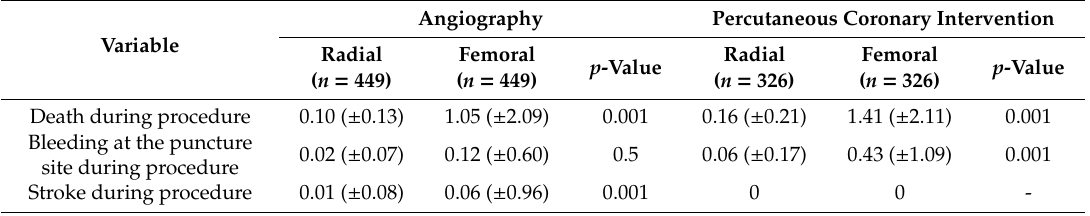
Table 10. Comparison of event rates between procedures with radial and femoral access site for stable angina and acute coronary syndrome in a group of operators performing ≥ 75% of procedures with radial